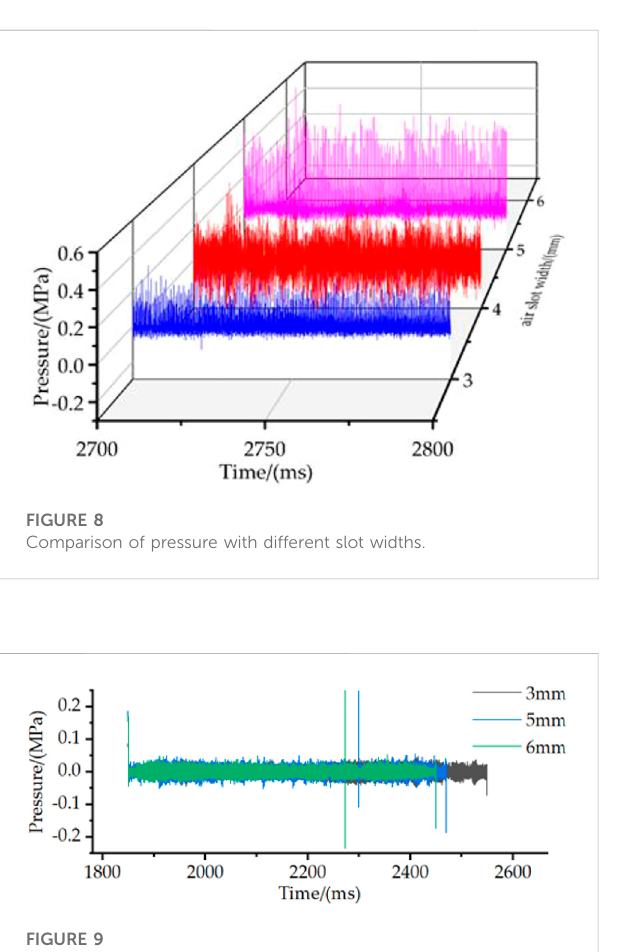
FIGURE 9 Comparison of pressure signals in the isolator.